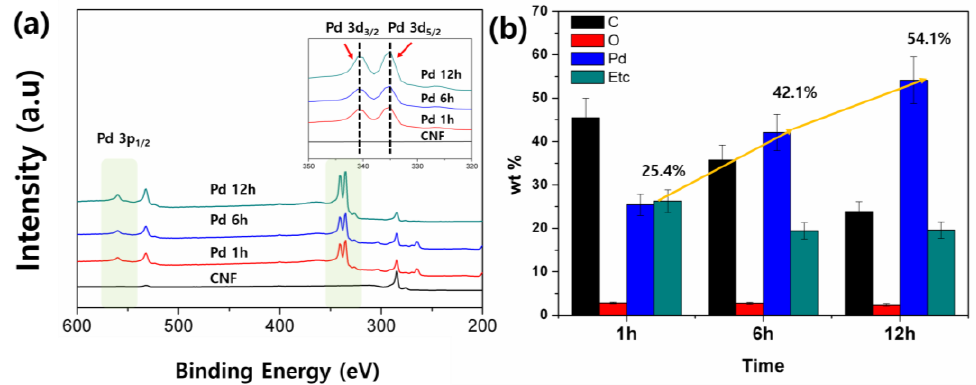
Figure 3. Probing Pd decoration process on CNFs. ( a ) The X-ray photoelectron spectroscopy (XPS) spectra of CNFs and Pd/CNFs with different deposition times. Inserted spectra magnified in Pd 3d peaks of Pd/CNFs; ( b ) elemental analysis conducted by energy dispersive X-ray (EDX) shows an increment in Pd content in CNFs as deposition time increases.